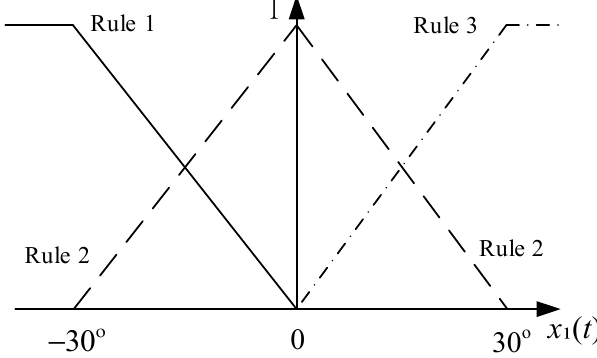
Figure 1. The membership functions of state ( )